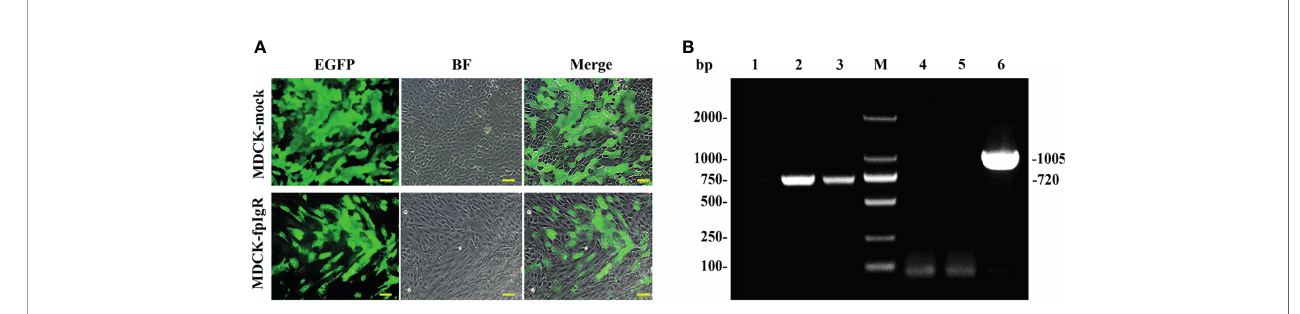
FIGURE 5 | Screening of two MDCK monoclonal cell lines stably expressing EGFP and fpIgR – EGFP fusion protein. (A) MDCK cells stably expressed pCIneoEGFP (MDCK-mock) and pCIneoEGFP-fpIgR (MDCK-fpIgR). Bar = 50 µm. (B) fpIgR transcription as detected by RT-PCR. M: Marker DL 2000; lanes 1 and 4: MDCK cells; lanes 2 and 5: MDCK-mock cells; lanes 3 and 6: MDCK-fpIgR cells.